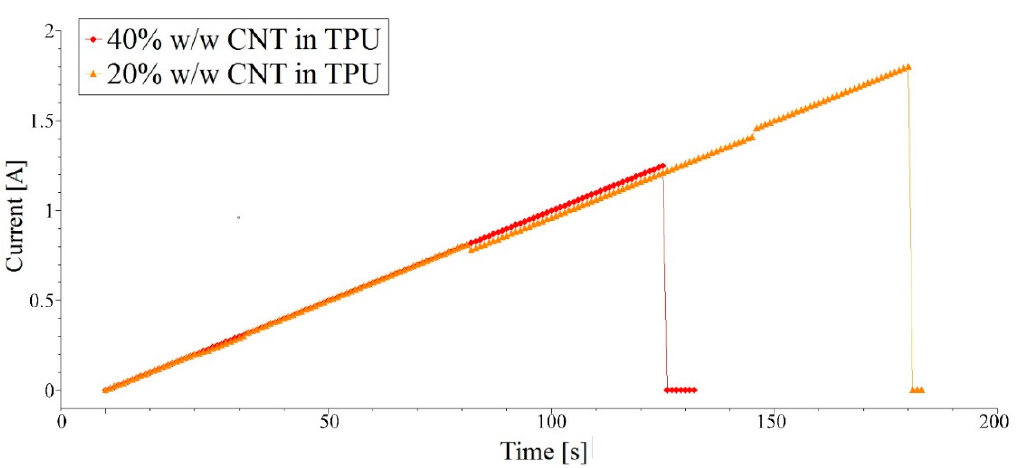
Figure 4. Measurements of the current carrying capacity of composite fibers, with 20% w / w and 40% w / w content of CNTs.